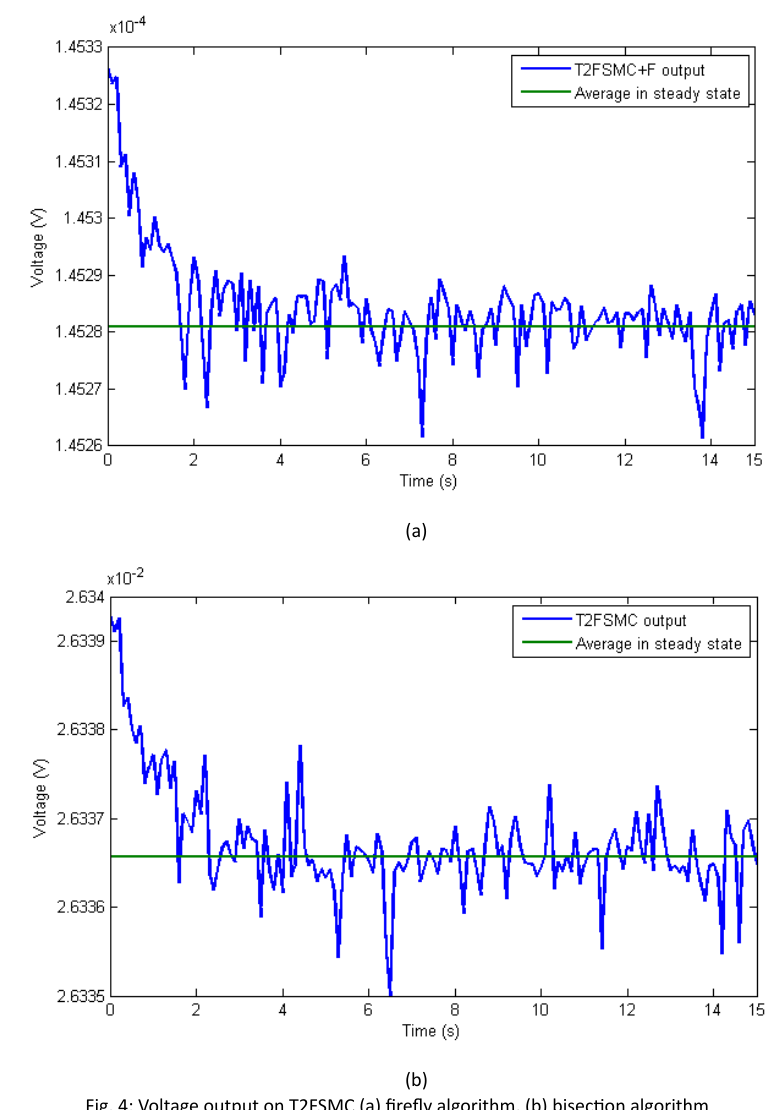
Fig. 4: Voltage output on T2FSMC (a) firefly algorithm, (b) bisection algorithm